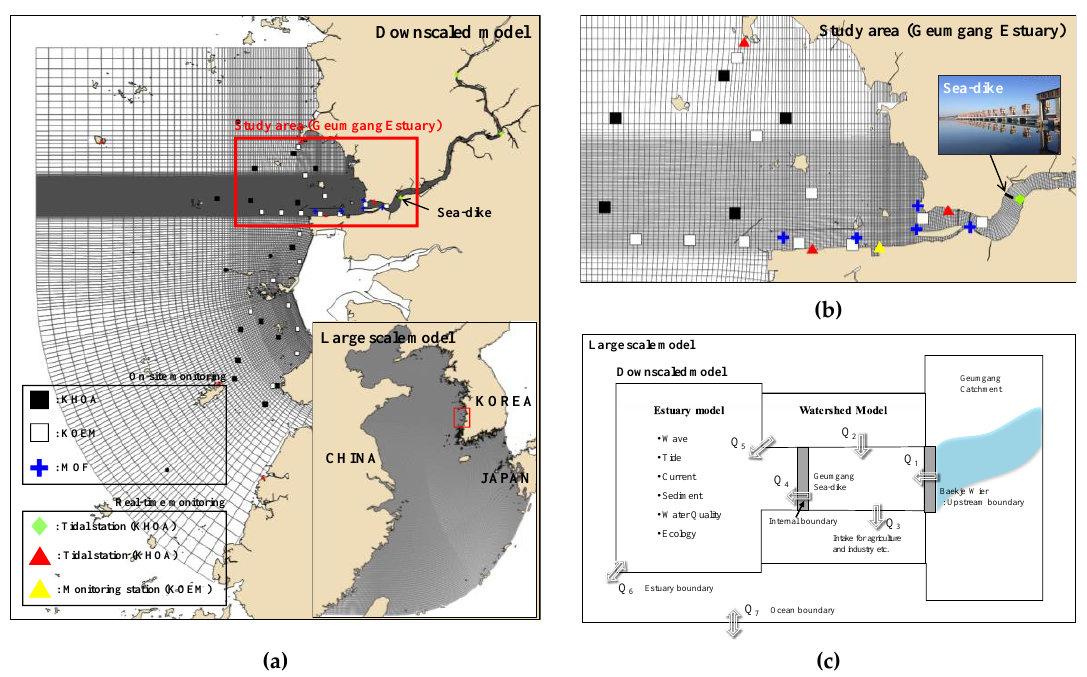
Figure 1. Monitoring status and computation grid of the ( a ) large scale model (117.88 ◦ E–131.36 ◦ E; 23.92 ◦ N–41.15 ◦ N) and downscaled model (125.85 ◦ E–127.01 ◦ E; 35.19 ◦ N–36.33 ◦ N), ( b ) Geumgang Estuary (126.3 ◦ E–126.8 ◦ E; 35.9 ◦ N–36.2 ◦ N) and position of the sea-dike (126.75 ◦ E; 36.02 ◦ N), and ( c ) concept of the integrated modeling. The abbreviations of KHOA, KOEM, and MOF imply Korea Hydrographic and Oceanographic Agency, Korea Marine Environment Management Corporation, Ministry of Oceans and Fisheries, respectively.